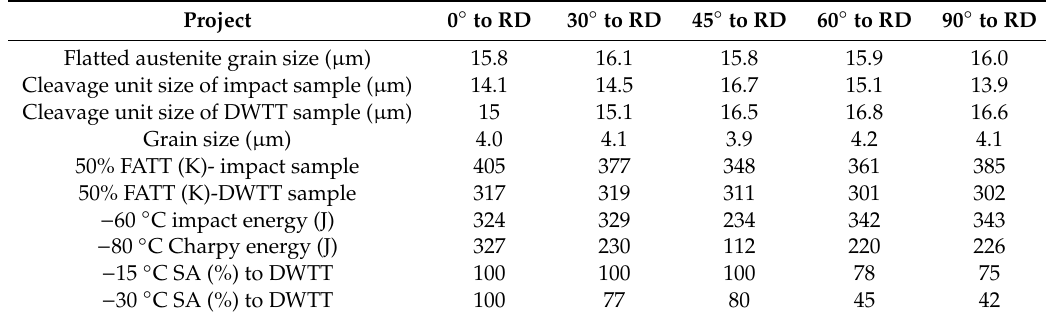
Table 4. Statistical diagram of microstructure unit size and